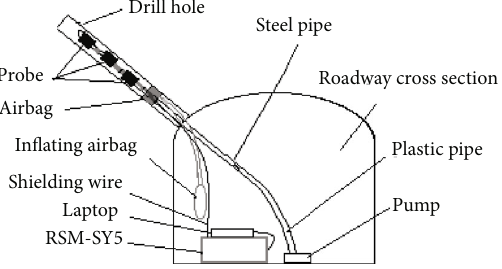
Figure 2: The diagram for testing the surrounding rock broken zone of an underground roadway.